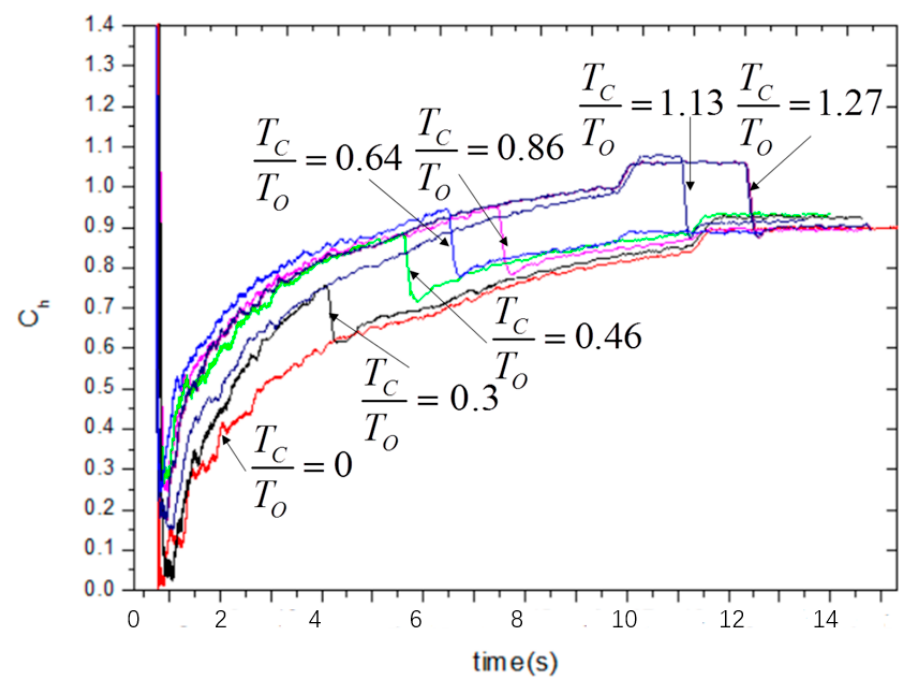
Figure 9. Dimensionless head for different startup periods.